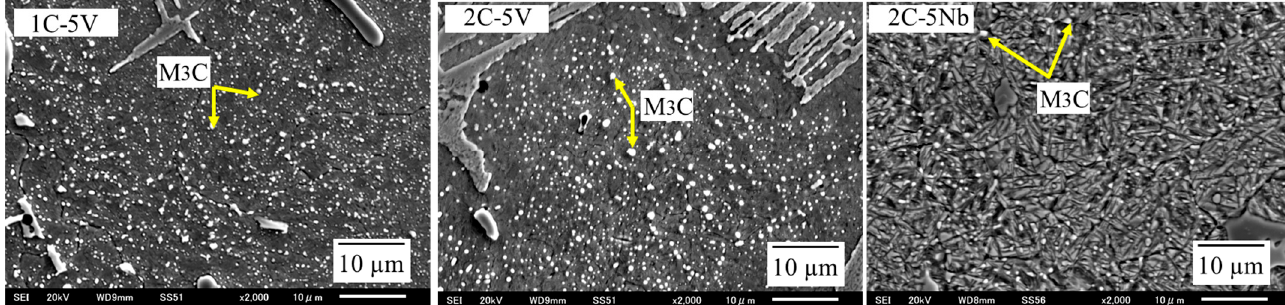
Figure 5. Higher-magnification microphotograph of the representative alloys. The precipitation of the secondary carbide (M 3 C) and martensite matrix (needle-like) on the microstructures of 1C-5V, 2C-5V, and 2C-5Nb.